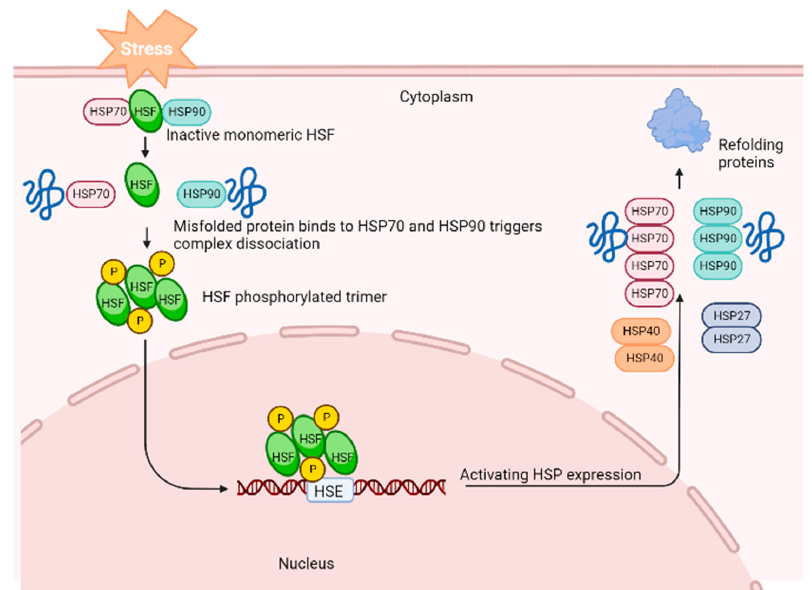
Figure 1. Activation of heat shock proteins’ activity in response to stressors. (Created with BioRen-